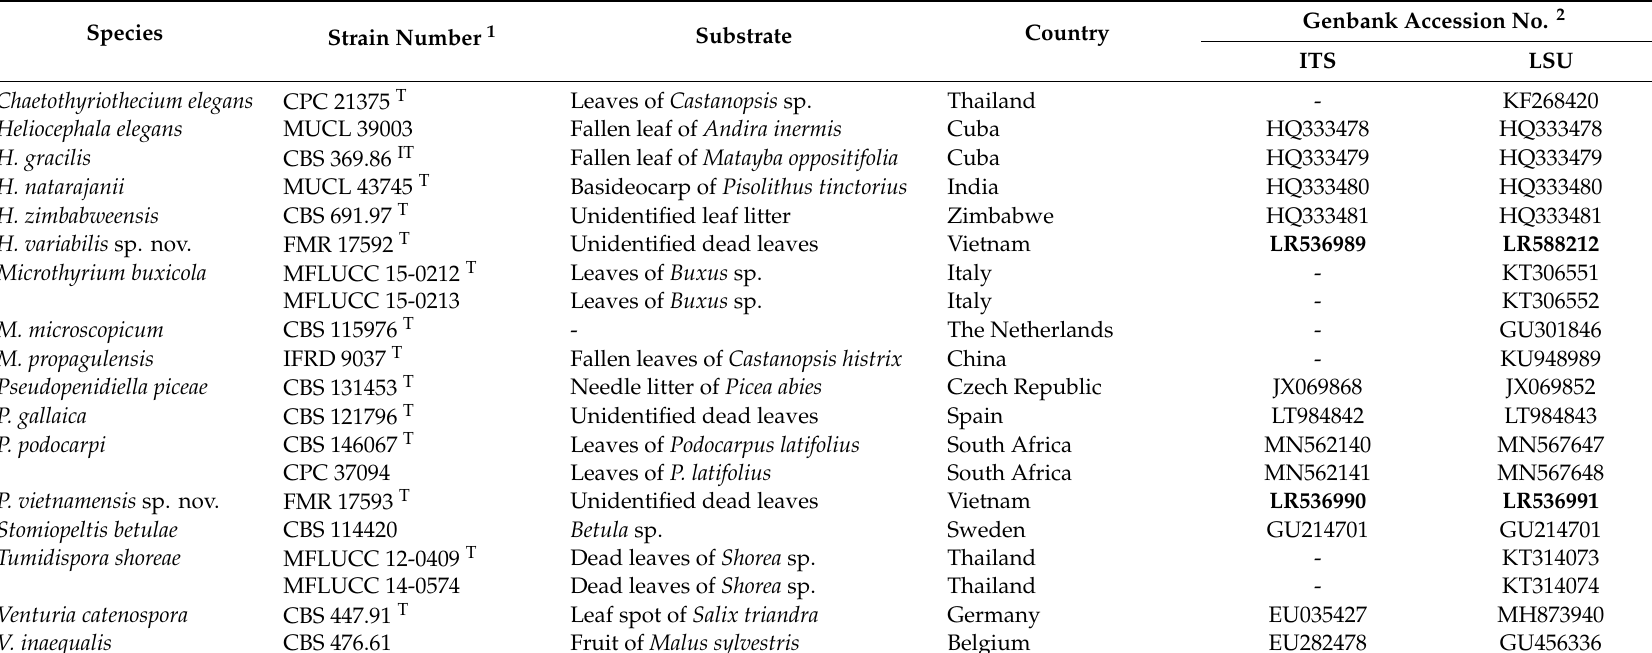
Table 1. Species included in this study, their substrate, origin, and GenBank accession